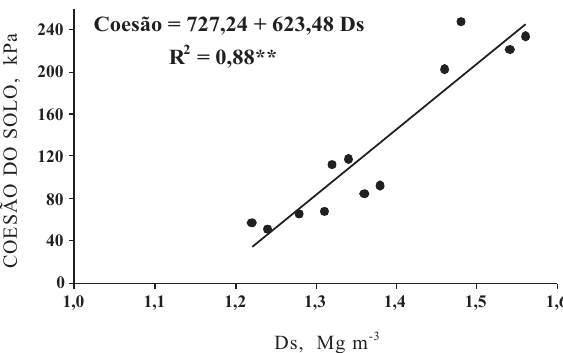
Figura 2. Coesão como variável da densidade (Ds) de um Latossolo Amarelo de São Miguel dos Campos, AL, no teor de água de 0,07 kg kg -1 .